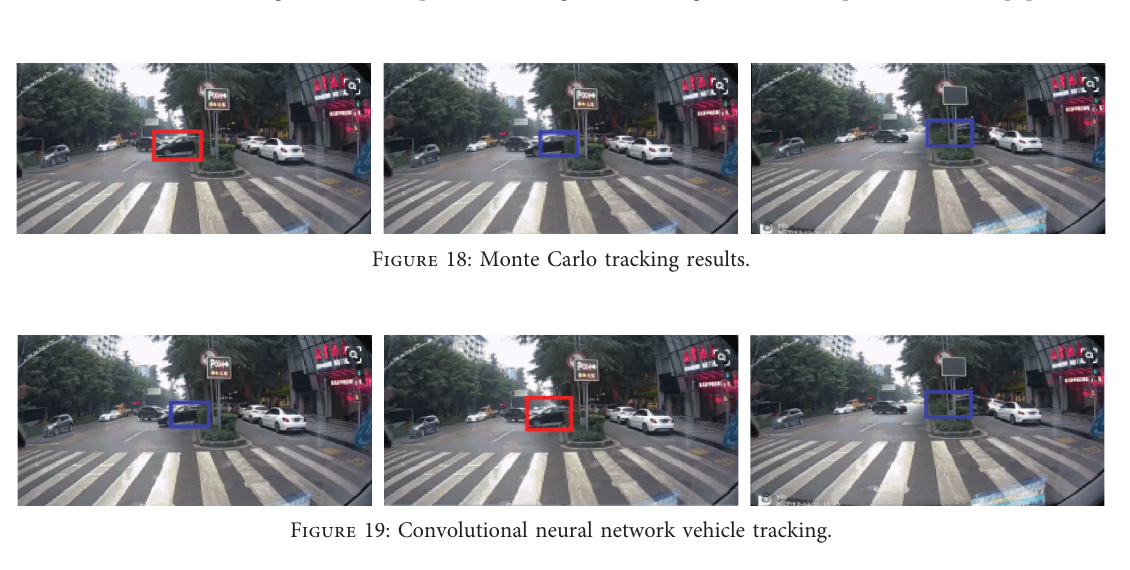
Figure 17: The tracking results of the particle filter algorithm for segmentation compensation in this paper.